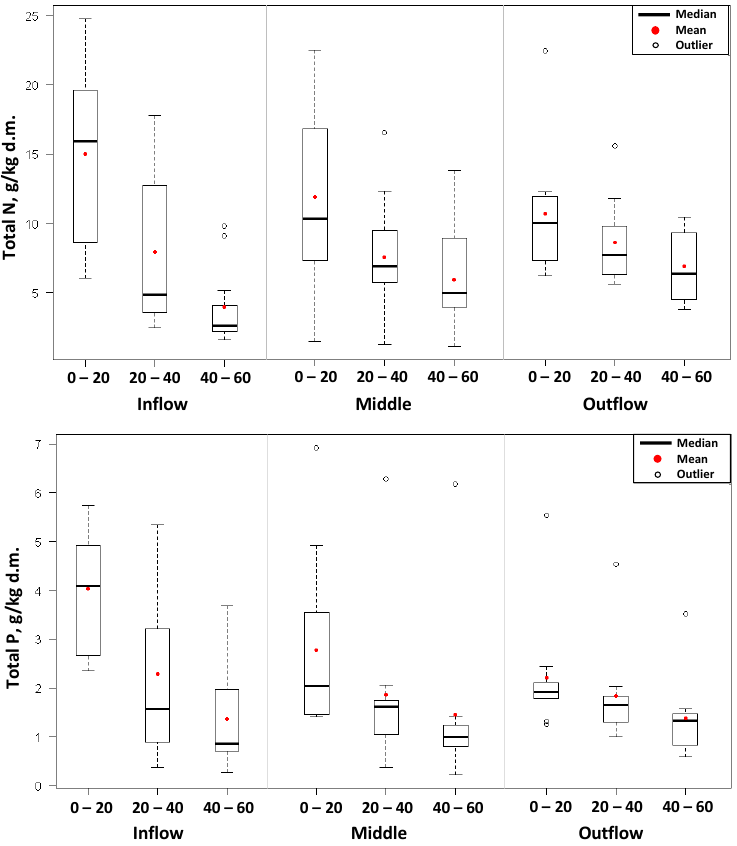
Figure 4. Accumulation of total nitrogen and phosphorus in the bed ( n = 10).